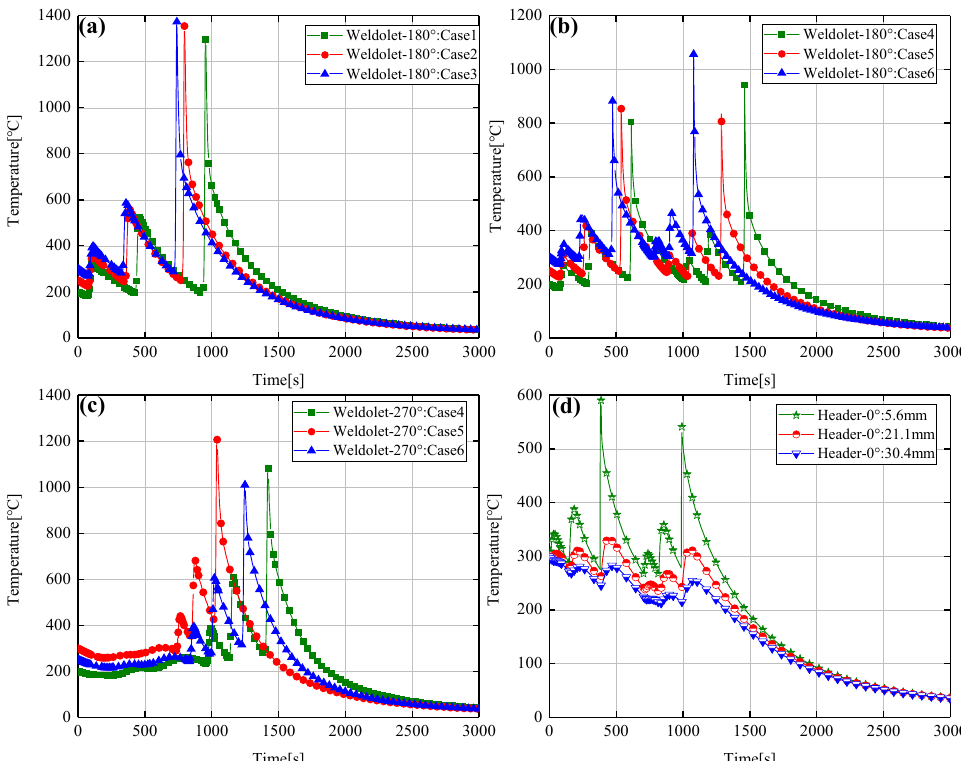
Figure 12. ( a ) Transient thermal cycling of the 180° section path-1, ( b ) Transient thermal cycling of the 180° section path-2, ( c ) Transient thermal cycling of the 270° section path-2, ( d ) Transient thermal cycling of the 0° section at 5.6 mm, 21.1 mm, 30.4 mm from the center of the weld.